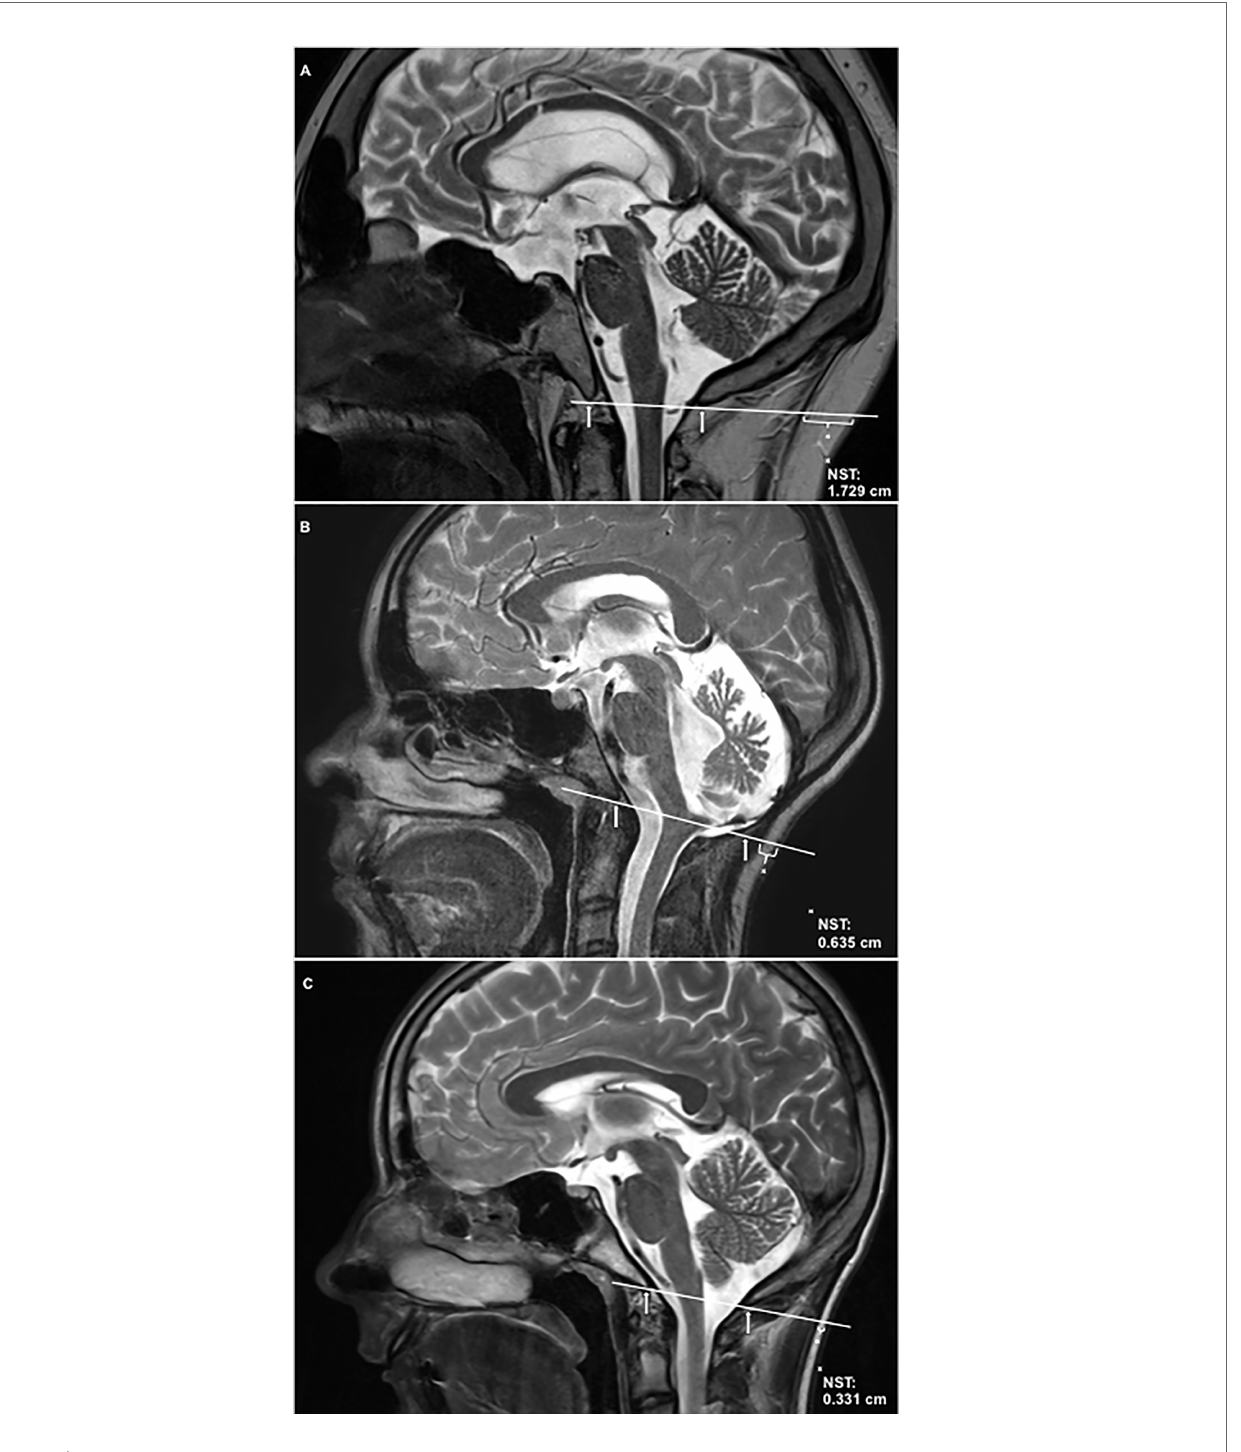
FIGURE 1 | Nuchal skinfold thickness (NST) is shown on T2-weighted sagittal cranial magnetic resonance imaging (MRI) of the midline. NST was quanti fi ed according to the following standardized assessment: First a line was drawn crossing the two anatomically de fi ned points: basion (anterior margin of the foramen magnum, indicated by arrow) and opisthion (posterior margin of the foramen magnum, indicated by arrow). The diameter of subcutaneous nuchal fat was measured over this line to the nearest 0.01 cm using OsiriX (Pixmeo SARL, Switzerland). (A) shows NST in a childhood-onset craniopharyngioma patient with severe obesity due to hypothalamic involvement [hypothalamic involvement grade II (13), body mass index (BMI): +4.86 SDS (32)]. (B) shows NST in a patient with low-grade glioma of the brain stem, BMI: +0.48 SDS. (C) shows NST in a healthy, normal-weight control [BMI: +0.41 SDS (32)]. SDS, standard deviation score. The inter-rater reliability of the used arithmetic mean of NST was